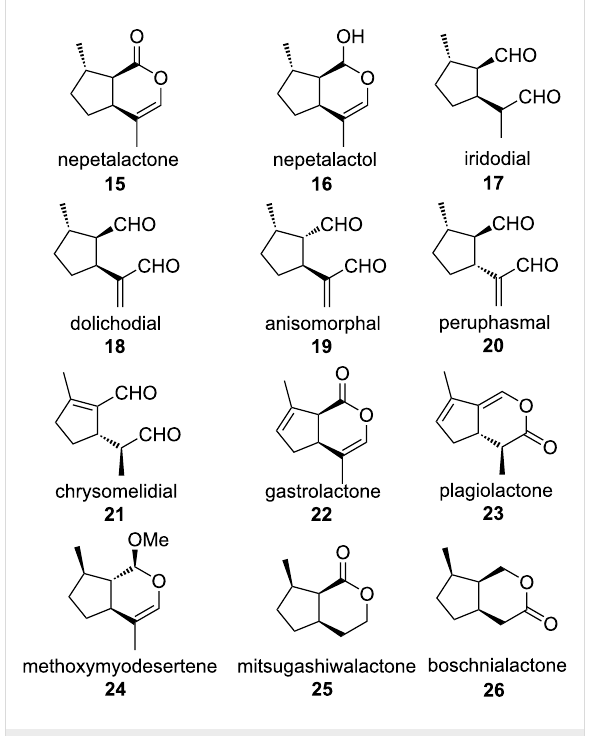
Figure 8: Structures of iridoids from insects and plants. Absolute configurations of 19 and 20 are "educated